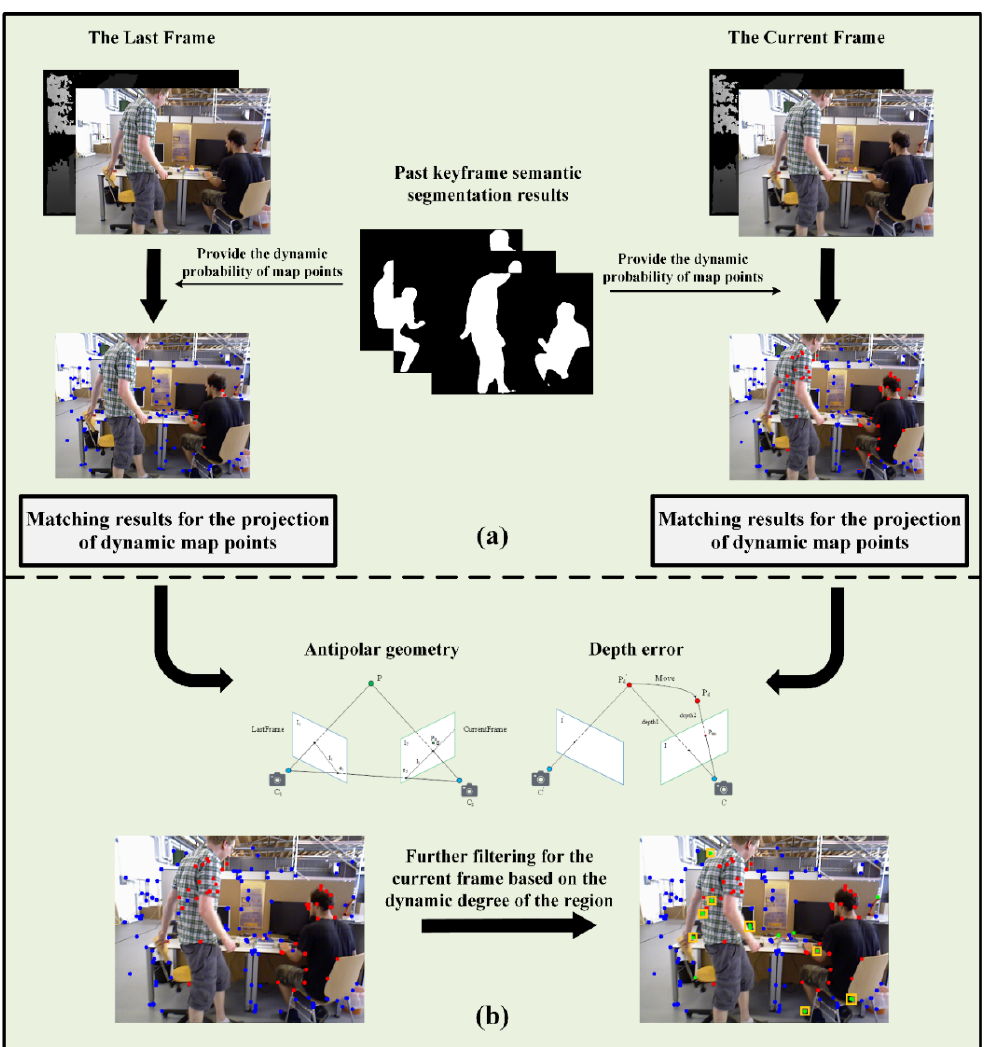
Figure 2. The dynamic point filtering method of SOLO-SLAM. ( a ) corresponds to the first round of filtering. ( b ) corresponds to the second round of filtering. The red points represent the map point projection identified as dynamic points in the first round of filtering. The blue points represent the map point projection identified as static points in the first round of filtering. The green points selected in the yellow rectangular box correspond to the points filtered in the second round.